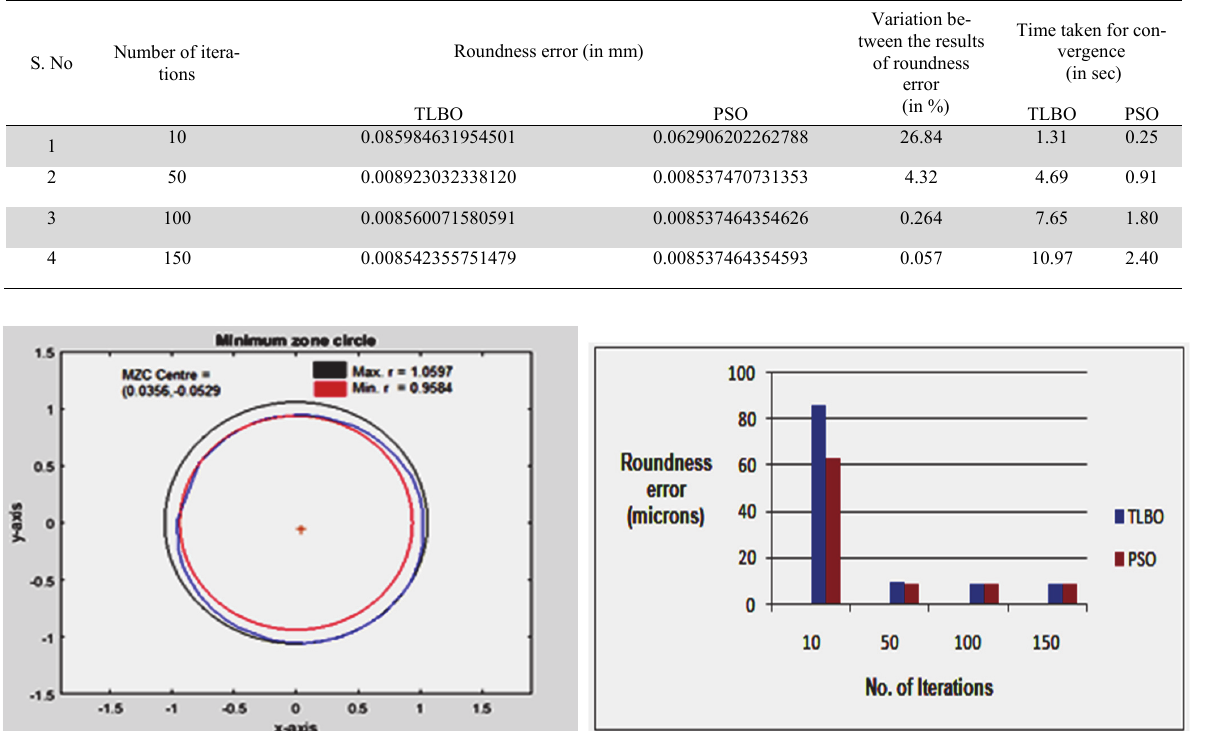
Fig. 4. Minimum zone circles obtained using TLBO